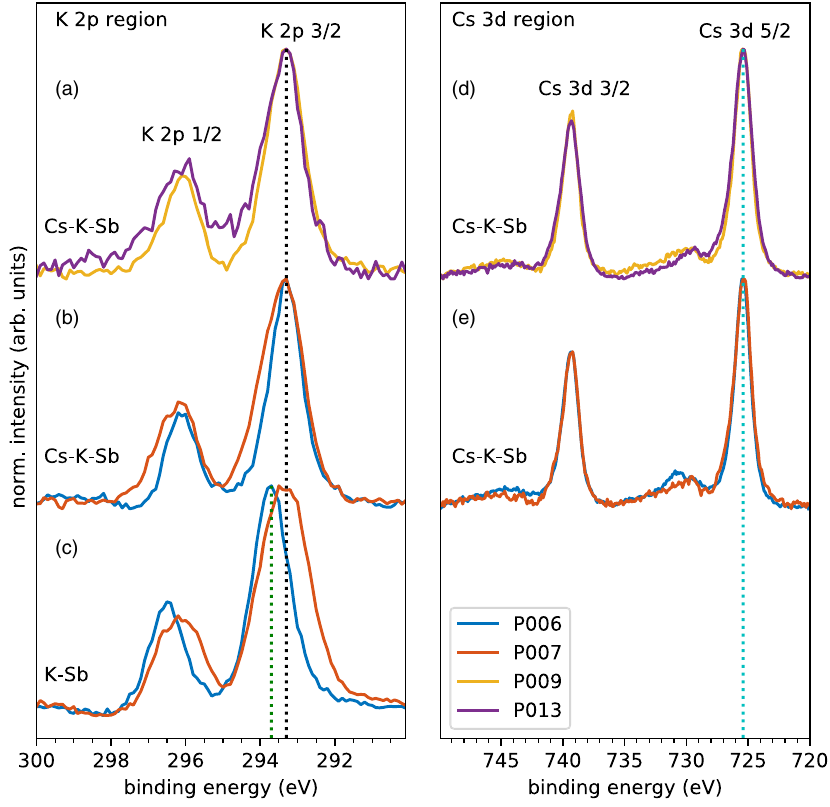
FIG. 3. Comparison of the K 2p (left) and Cs 3d (right) spectra of each sample. The color code holds for both panels. Note the shift in the P006 K 2p spectra between the K-Sb and Cs-K-Sb layer (b and c, blue lines). The K 2p and Cs 3d spectra of the Cs-K-Sb layer of the other samples show no difference in terms of binding energy and peak shapes (a and